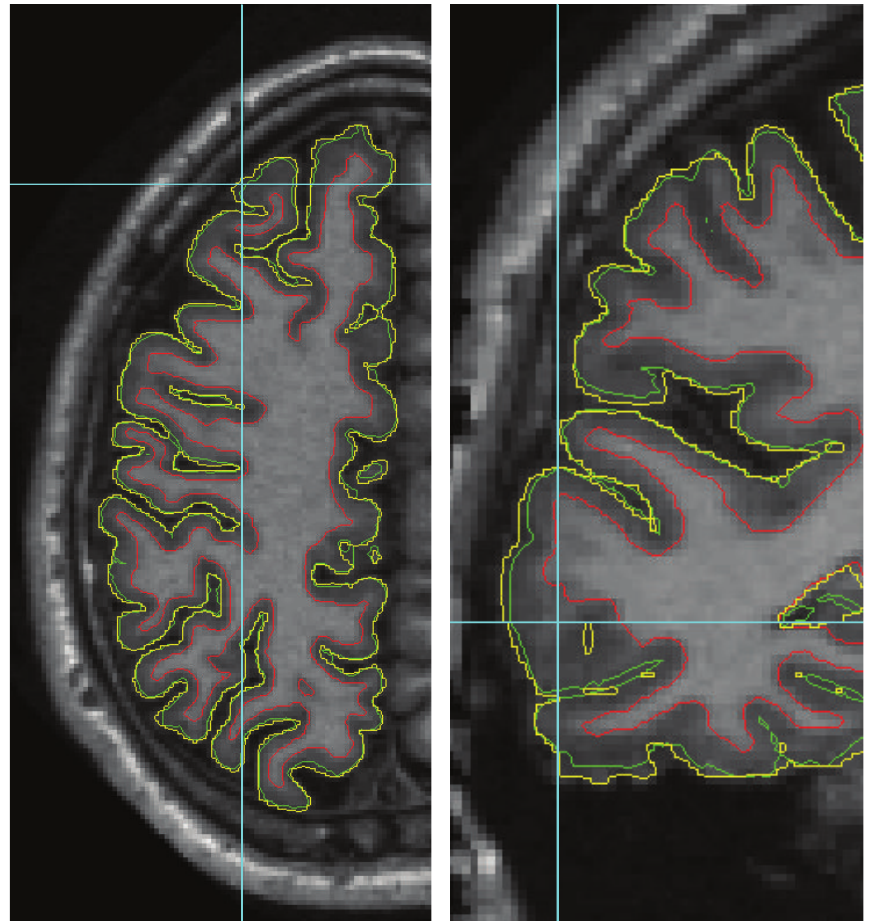
Figure 10: Contours of reconstructed cortical surfaces overlaid on the axial (left) and coronal (right) slice (red: inner surface; green: DELFMAP pial surface; yellow: FreeSurfer pial surface; note that the yellow contour appears jagged because it is displayed from FreeSurfer’s volumetric signed distance function sampled at 1mm grid, whereas red and green contours are from level set functions sampled at a finer resolution; left and right images are not to scale). On the left image at the cross-line cursor position (superior frontal region), the yellow contour of FreeSurfer’s pial reconstruction oversegments into meningeal space, and a similar trend is noticeable next to cursor on the right image (temporal